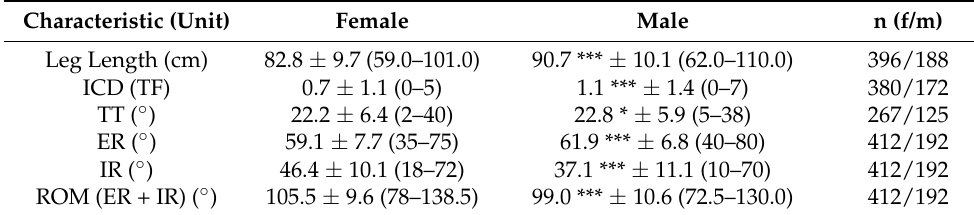
Table 4. Legs and hips by gender, Mean ± SD (Range).